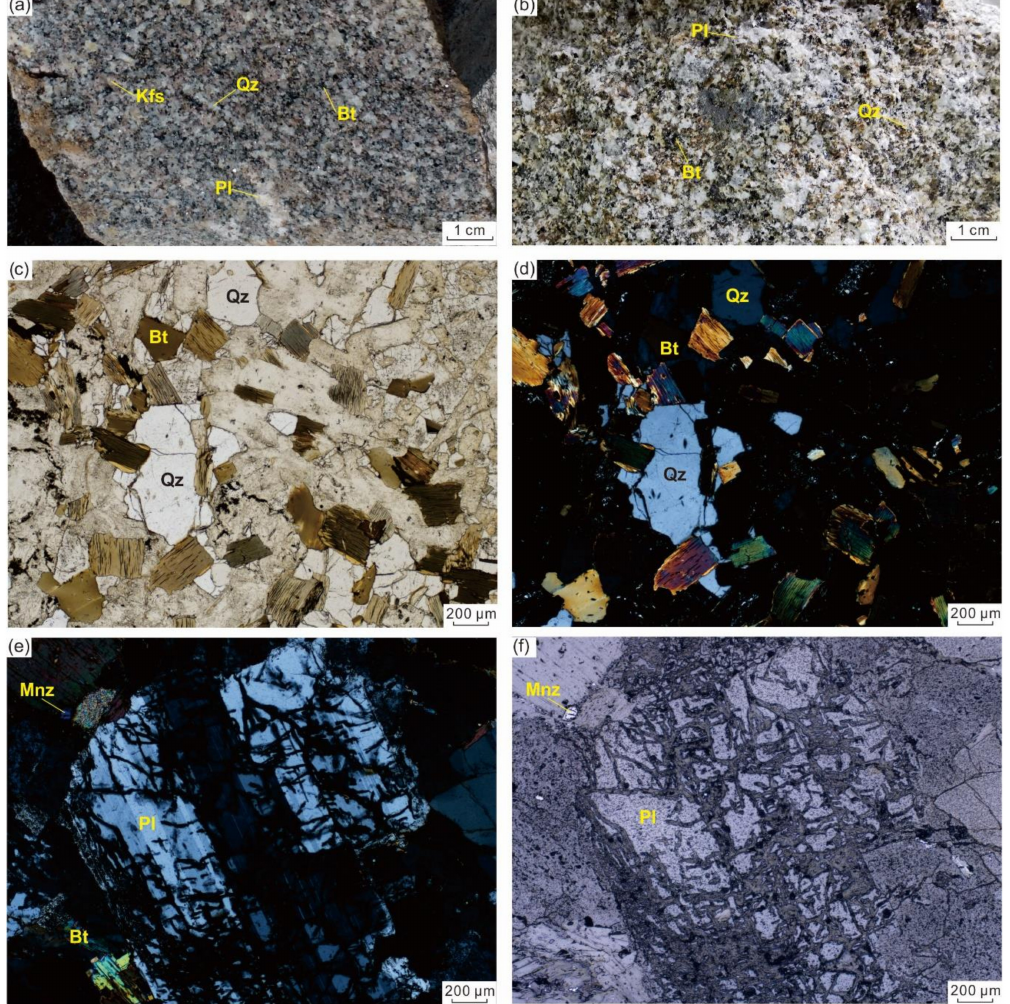
Figure 3. ( a , b ) representative photographs of hand-specimens from the Bozhushan batholith, showing the fine-medium grained texture of biotite monzogranite. ( c , d ) microphotographs of sheeted biotite and paragenetic quartz under plane-polarized light and cross-polarized light. ( d – f ) microphotographs of cataclastic plagioclase and intergrown quartz, with interstitial sparse monazite in quartz. Mineral abbreviations: Bt = Biotite; Kfs = K-feldspar; Mnz = monazite; Pl = Plagioclase; Qz =